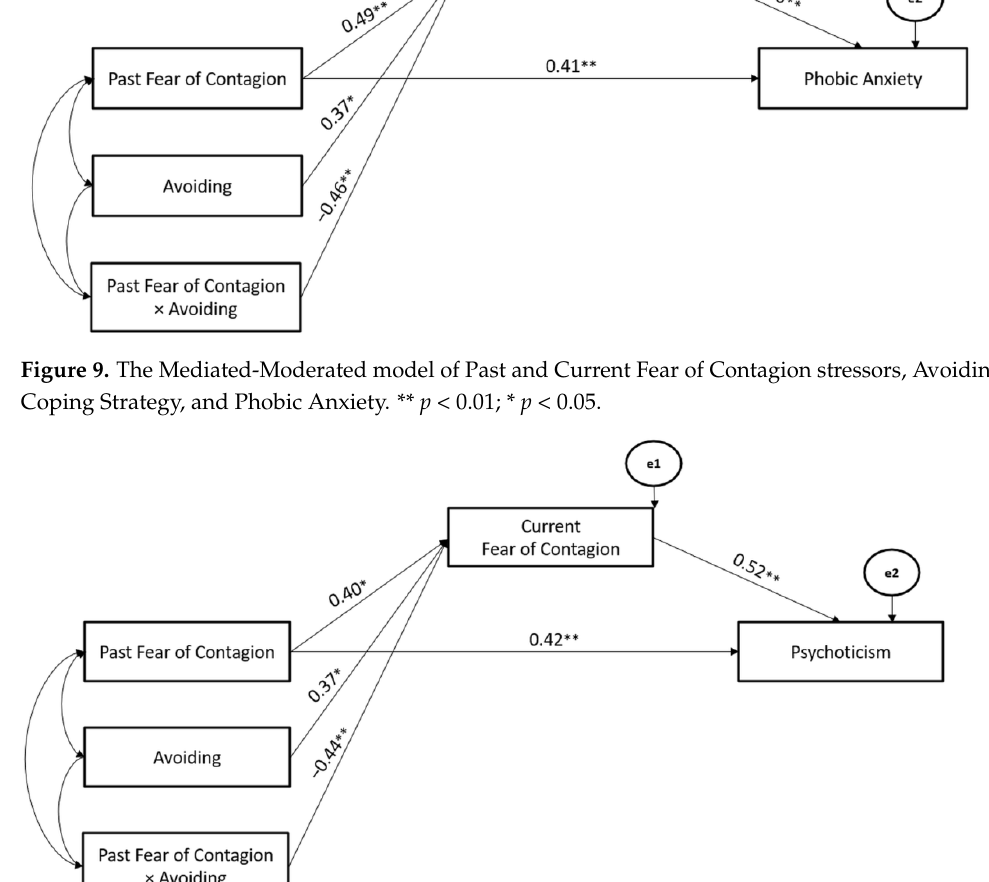
= 103.76, GFI = 0.94, TLI = 0.96, CFI = 0.97, and RMSEA = 0.05) (Hypothesis 4) (Figure 10).